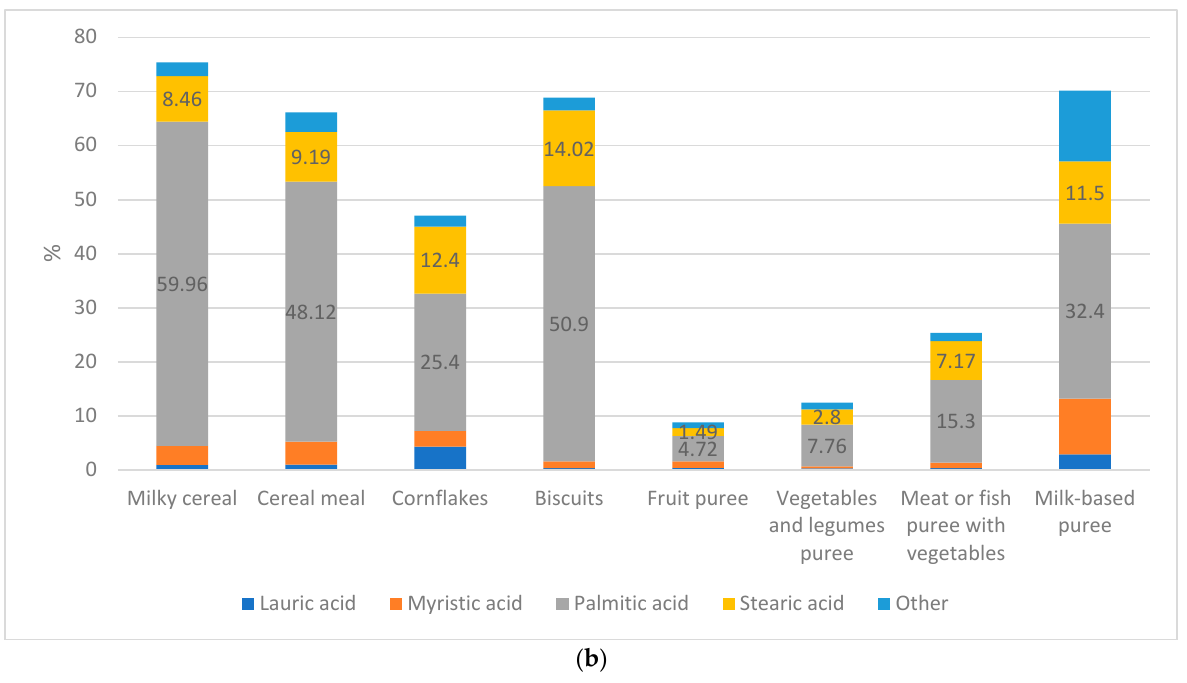
Figure 2. ( a ) Percentage of saturated fatty acids distribution (from total fatty acids) in infant formula: starting formulas (0–6 months); follow-up formulas (6–12 months); growing-up formulas (1–3 years); and extra-care formulas (0–12 years). ( b ) Percentage of saturated fatty acids distribution (from total fatty acids) in baby food products that targeted children aged 6 months and plus. Other: Butyric acid, Caproic acid, Caprylic acid, Capric acid, Undecanoic acid, Tridecanoic acid, Pentade- canoic acid, Heptadecanoic acid, Arachidic acid, Heneicosanoic acid, Behenic acid, Tricosanoic acid, Lignoceric acid.